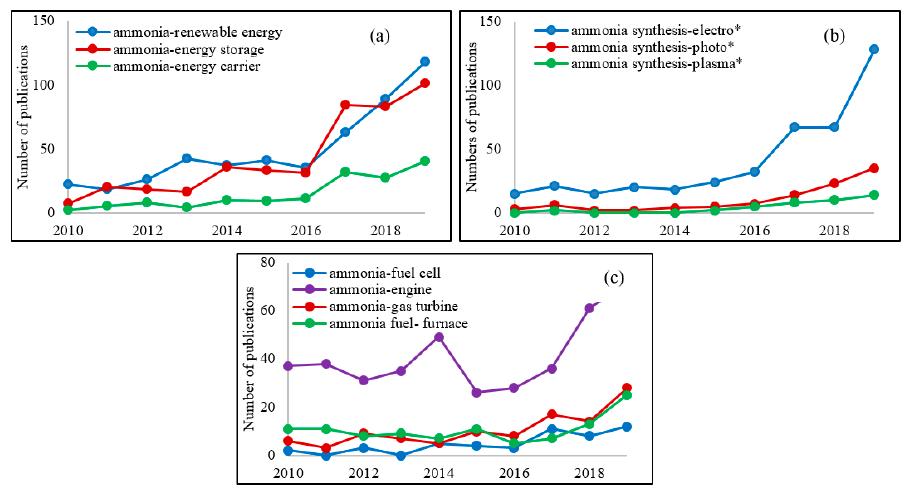
Figure 2. Recent publications of ( a ) ammonia as a renewable energy carrier, ( b ) innovations in ammonia production, ( c ) ammonia as a fuel in Scopus databases.